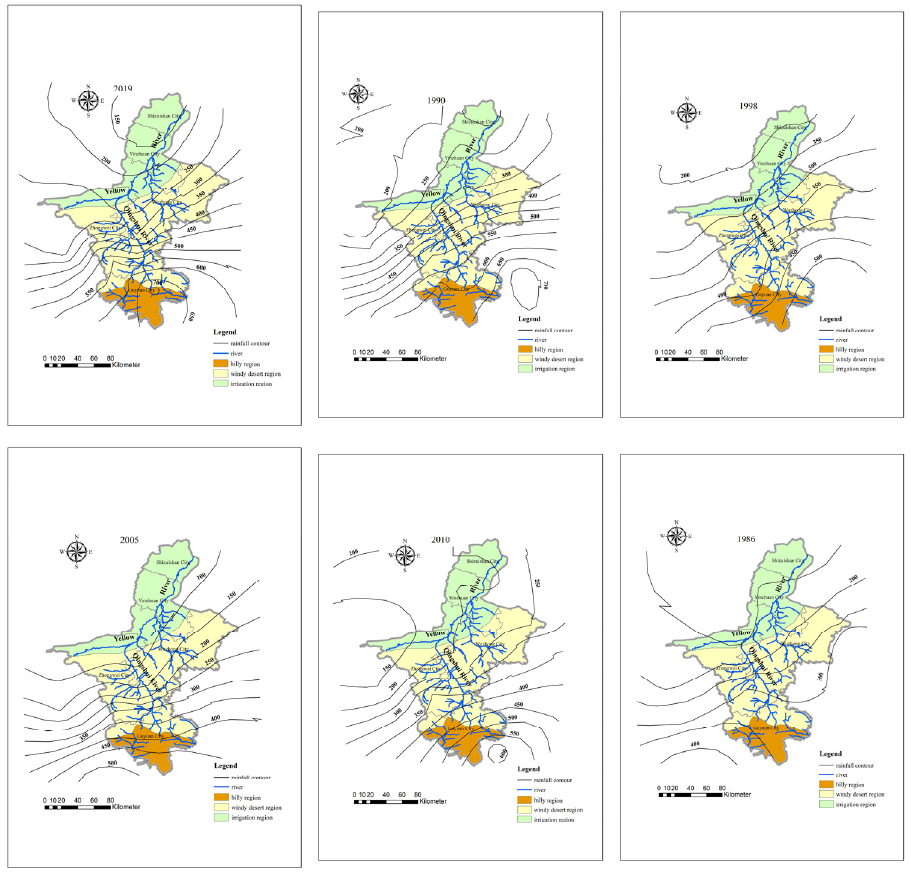
Figure 10. Distribution of rainfall contours in different years. Based on the average value of the interpolated area, the annual average precipitation changes in the Yellow Irrigation Area since 1986 were obtained (Figure 11). For the year-to- fluctuation changes, with the highest rainfall level being about 270 mm in 2002 and the lowest precipitation being less than 80 mm in 2005, and in general, the Yellow Irrigation Area is still a typical drought